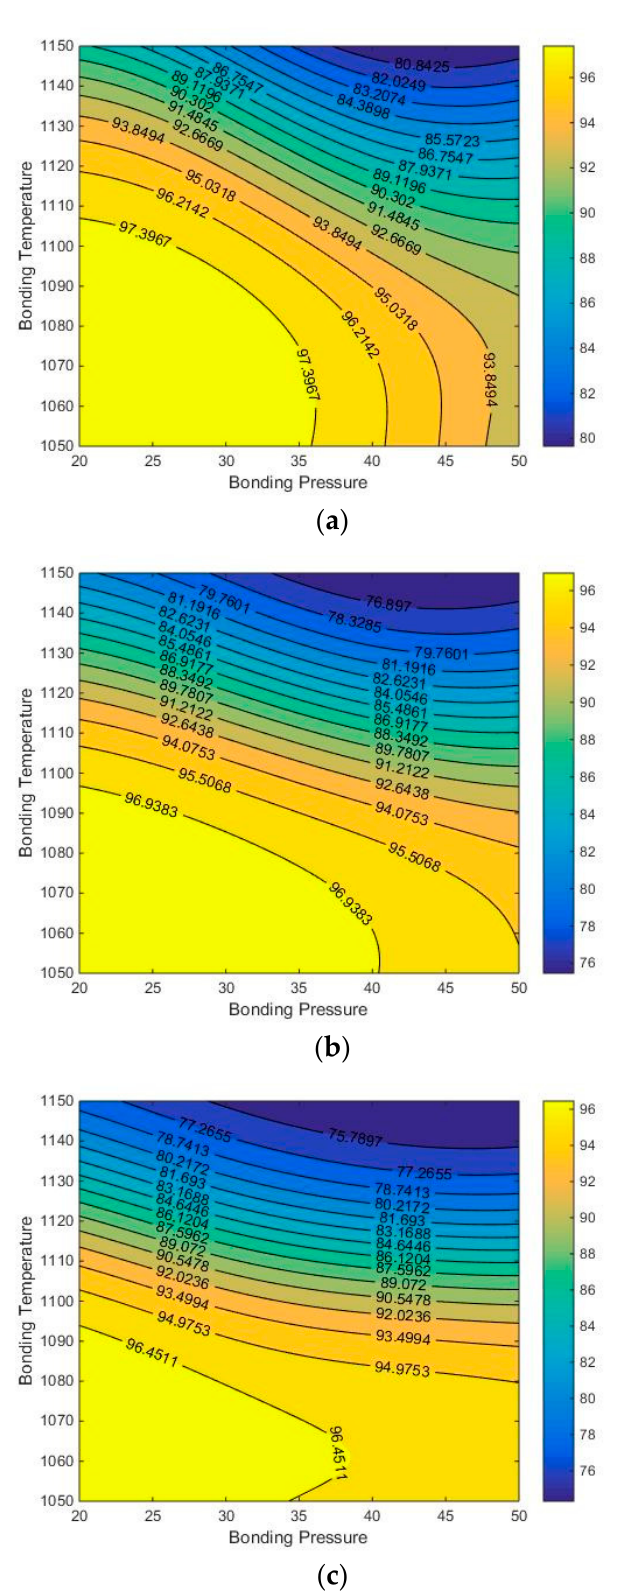
Figure 8. The double-factors contour map of deformation ratio: ( a ) t = 30 min; ( b ) t = 60 min; ( c ) t = 90 min.